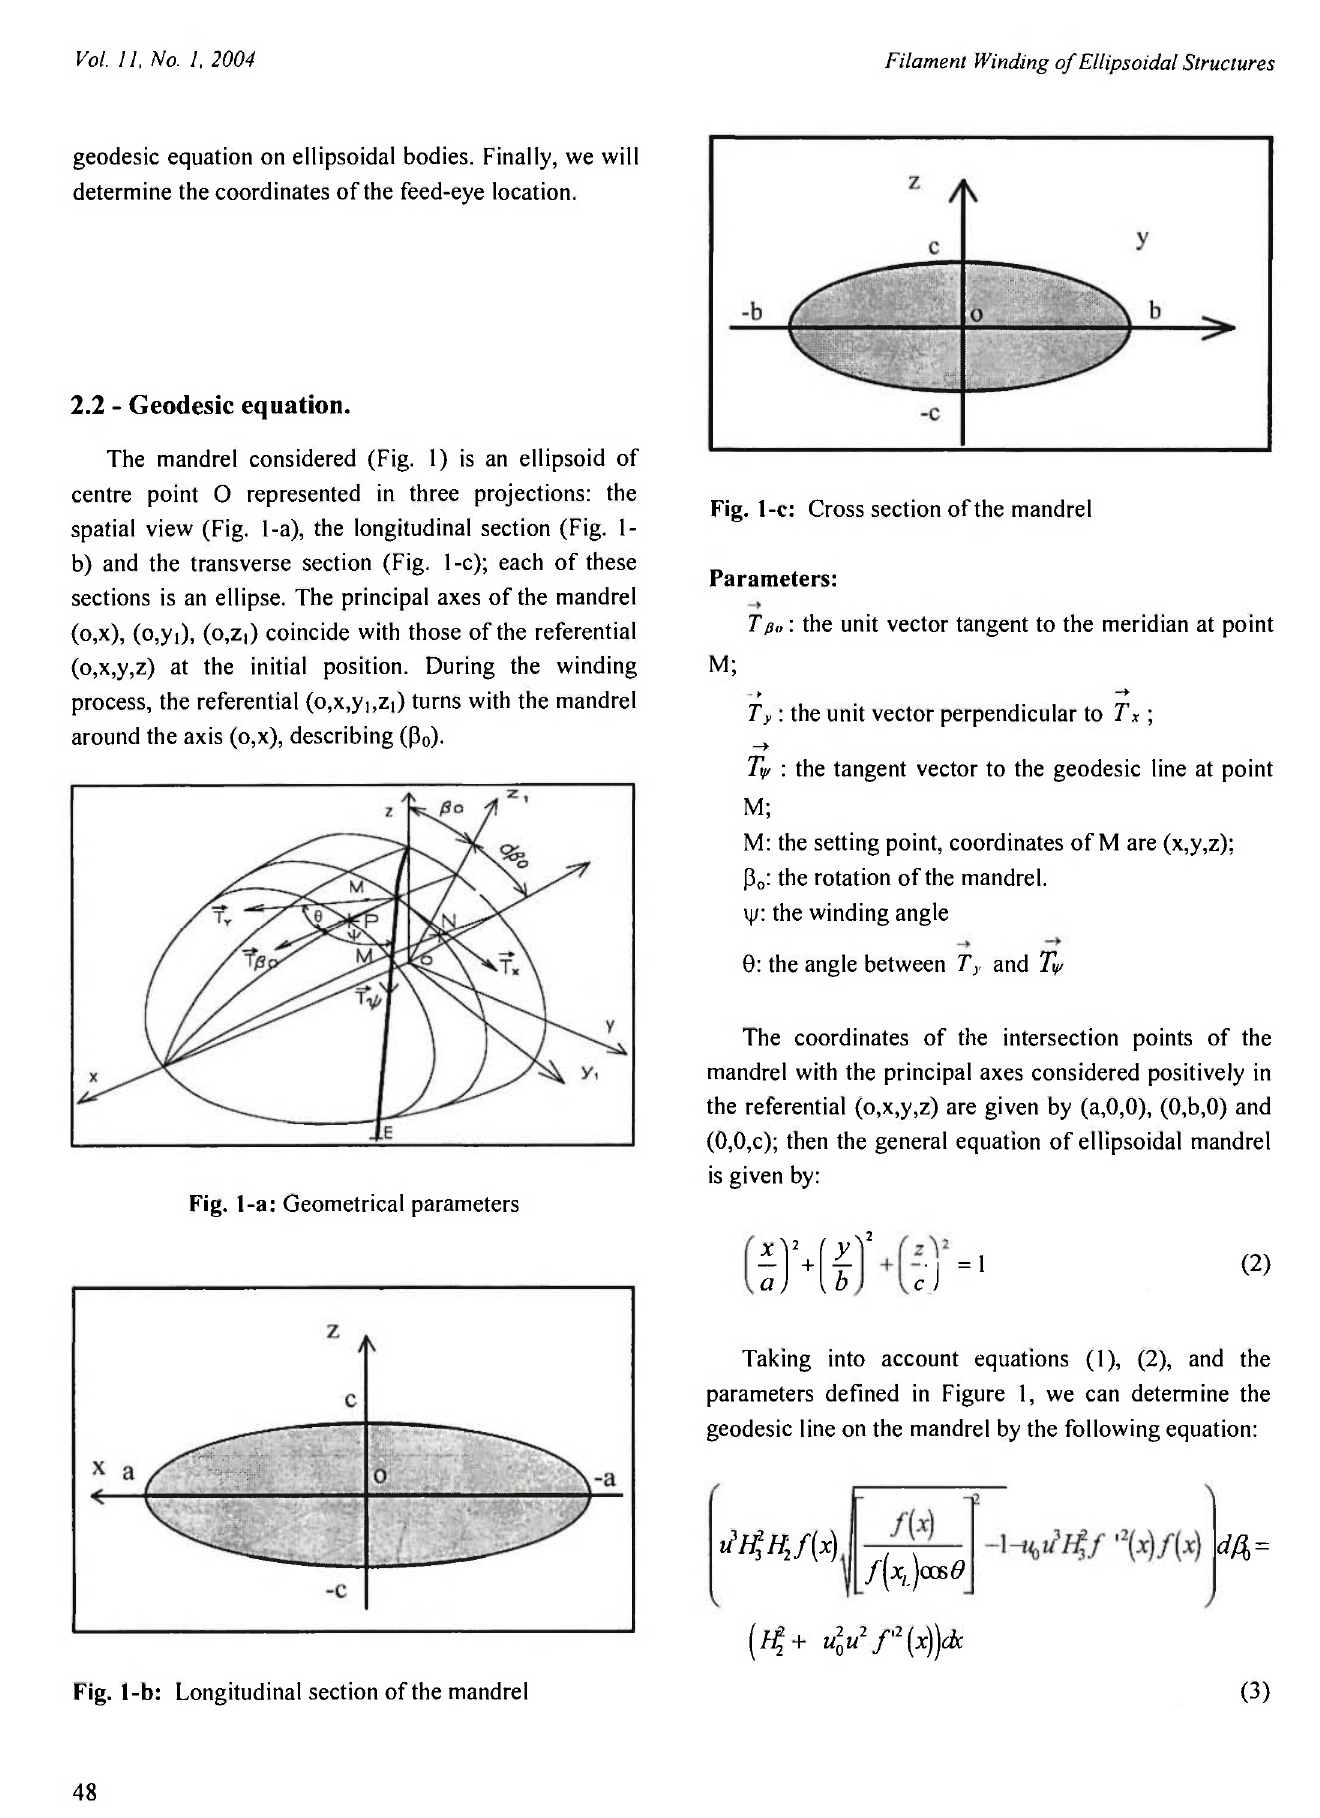
Fig. 1-b: Longitudinal section of the